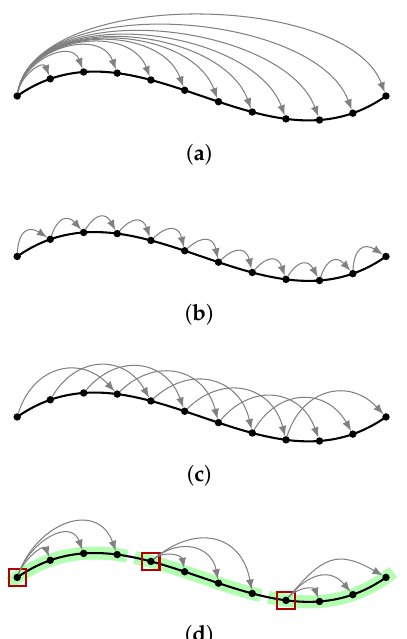
Figure 2. Different ways to define the reference frame for relative coordinates used in calibration. n , and ( d ) i = k s . In ( d ) the individual segments are highlighted in ( a ) i = 0, ( b ) i = j 1, ( c ) i = j − − green with the corresponding keyframe k s marked with a red